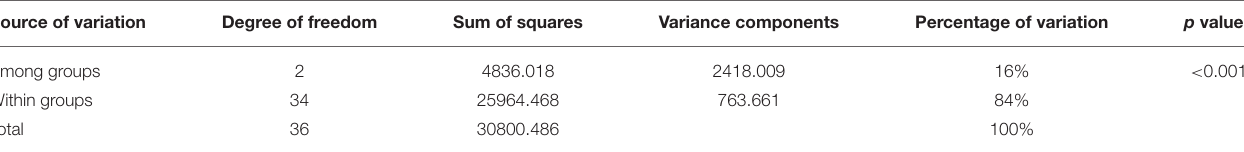
TABLE 2 | Number of effectives alleles ( Ne ), Shannon’s information index ( I ), heterozygosity observed ( h ), percentage of polymorphic loci ( PPL ), and private alleles in durum collection and in the three groups (MDC, TDL-1, and TDL-2) defined by phylogenetic analysis.